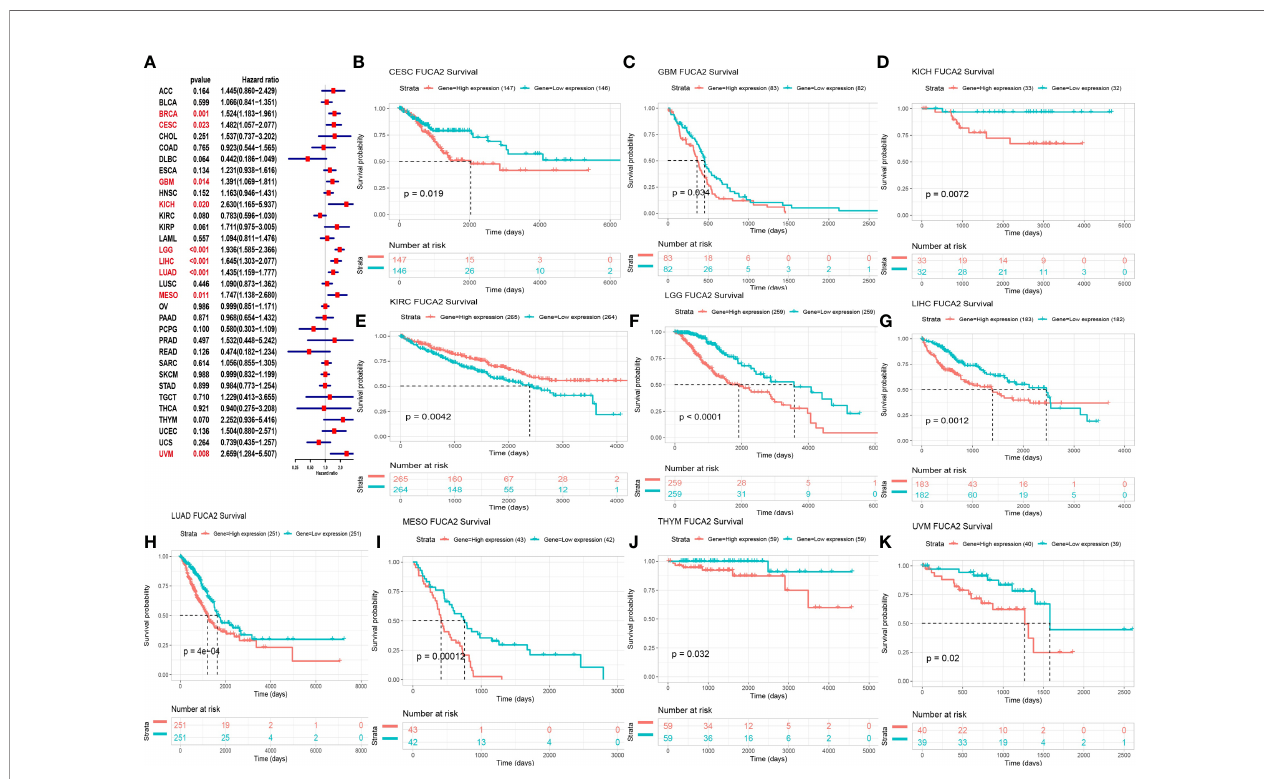
FIGURE 3 | Relationship between FUCA2 level and OS. (A) Forest plot showing OS after Cox analysis in pan-cancer. Red color represents signi fi cant results (p < 0.05). (B – K) Kaplan-Meier curves showing OS in pan-cancer. Only signi fi cant results were